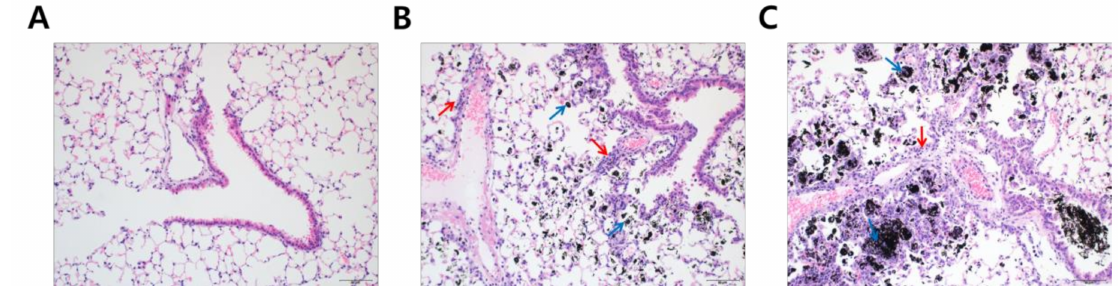
Figure 2. Soot accumulation in the experimental lung after diesel exhaust particles (DEP) exposure. Lung tissues were microscopically evaluated with hematoxylin and eosin staining (20 × ). The panels represent mice treated with ( A ) distilled water; ( B ) 5 mg/kg of DEP (DEPL); and ( C ) 15 mg/kg of DEP (DEPH) for 7 consecutive days. Blue arrows in ( B , C ) point to black-pigment-laden macrophages in the alveoli and alveolar lumen interstitium. Red arrows in ( B , C ) indicate the infiltrated inflammatory cell in peribronchiolar, perivascular, and interstitial